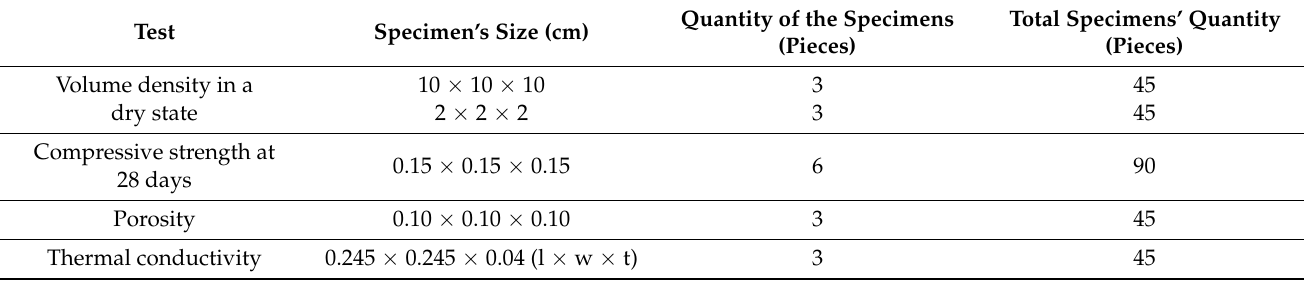
Table 3. The specimens for